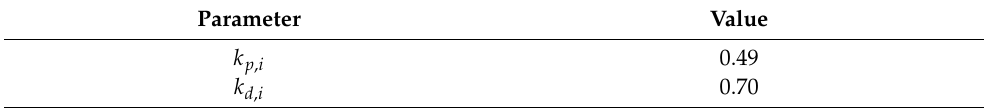
Table A1. Model-based PDFF controller parametrization.